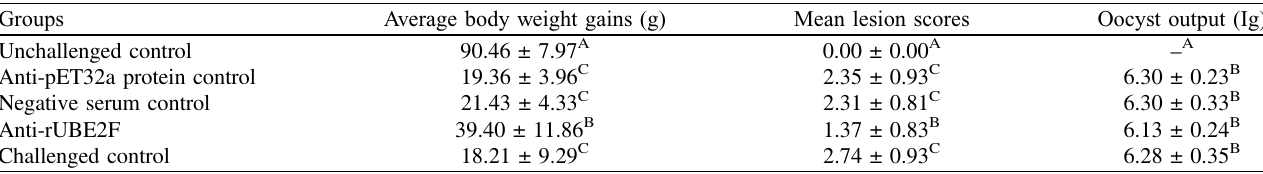
Table 1. Effects of antiserum against rUBE2F during E. acervulina challenge on different parameters.